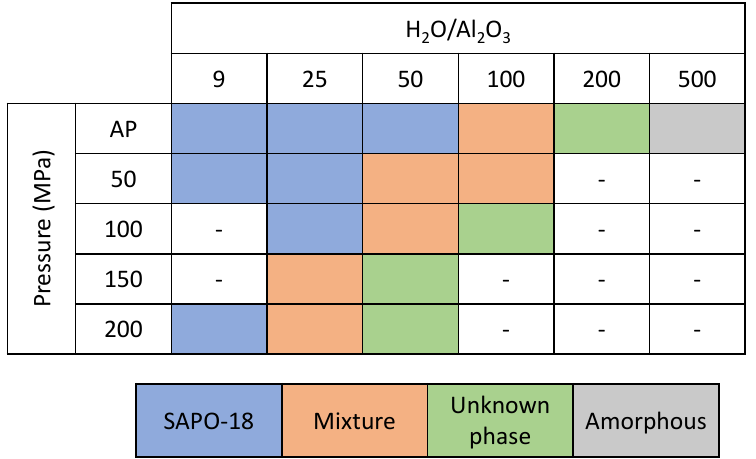
Figure 7. Products obtained with different synthesis mixture concentrations at 150 °C under AP, 50, 100, 150 and 200 MPa of external hydrostatic pressure. SEM images of SAPO-18 samples obtained under AP, 50 and 200 MPa are shown in Figure 8. All solids present big spheric particles of 17 µ m of diameter formed by the agglomeration of small crystals. The size of these cuboid primary crystallites increases with the synthesis pressure, from 0.5 × 0.1 µ m in the AP sample, to 4 × 0.5 µ m of SAPO-18 obtained under 200 MPa.